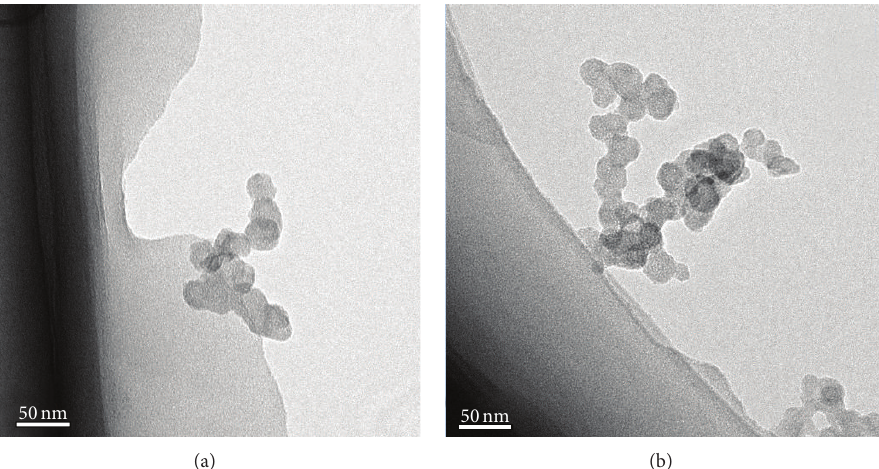
Figure 1: TEM photographs of diesel particulates sampled at (a) 2000 rpm/25% load when fueled with pure diesel and (b) 2000 rpm/75% load when fueled with blended fuel containing